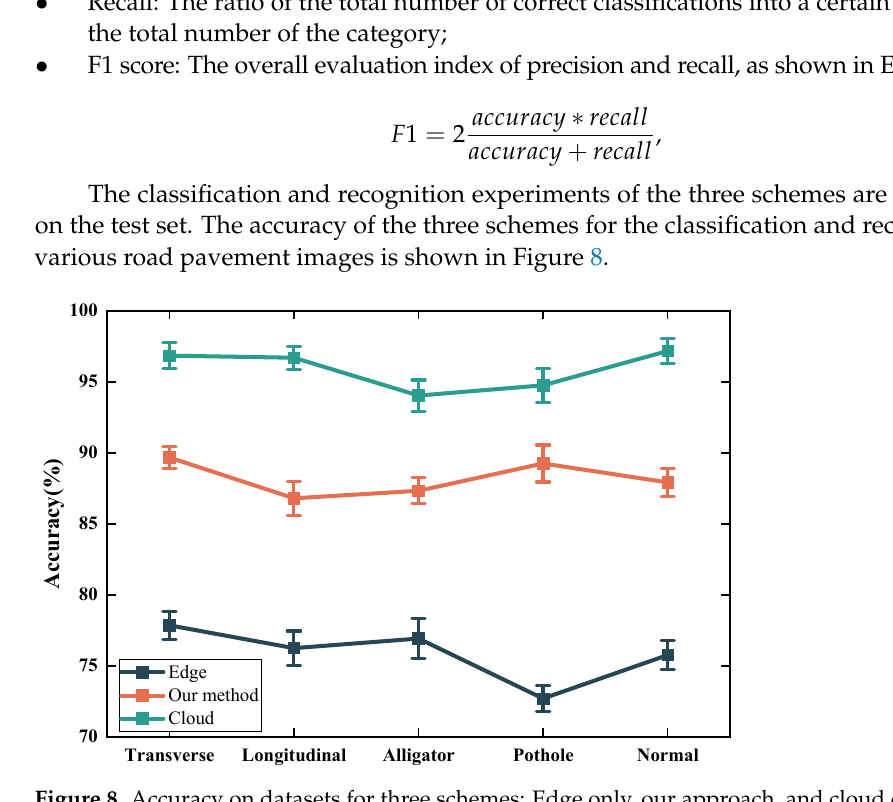
Figure 8. Accuracy on datasets for three schemes: Edge only, our approach, and cloud only. Table 1. Average recall and F1 score for various road surface images on datasets only at the edge, in our method, and in the cloud.